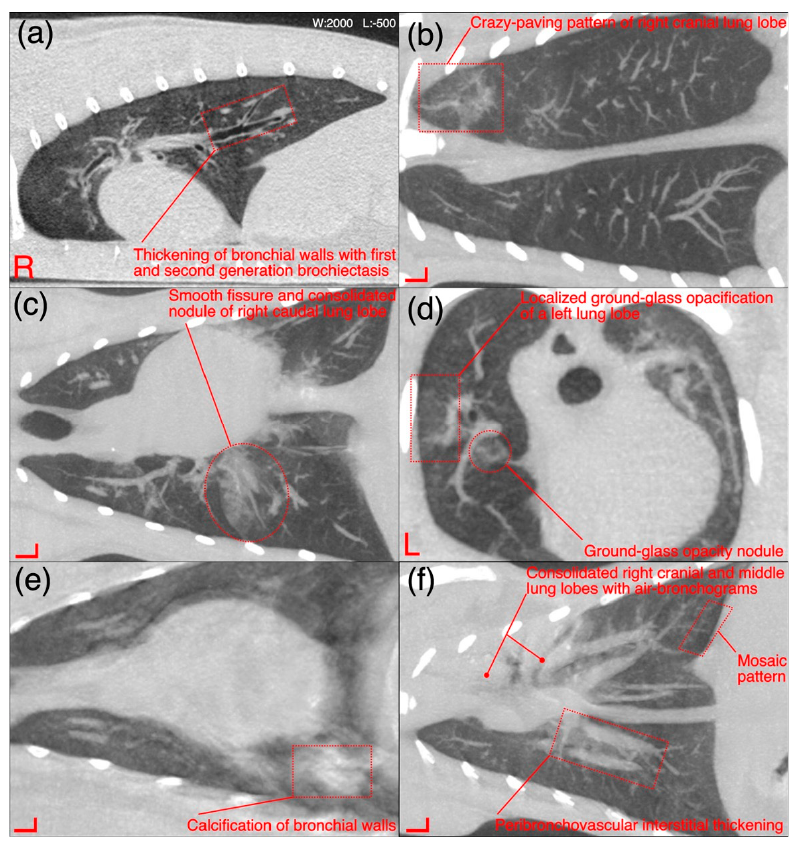
Figure 12. ( a – f ) A variety of computed tomographic changes of pulmonary parenchyma and its related vasculature are labeled for pathologies related to acute/chronic infectious respiratory disease signs in Cats 5, 8, 12 and 21. Window and level are same for all sections and laterality is also labeled for each side.